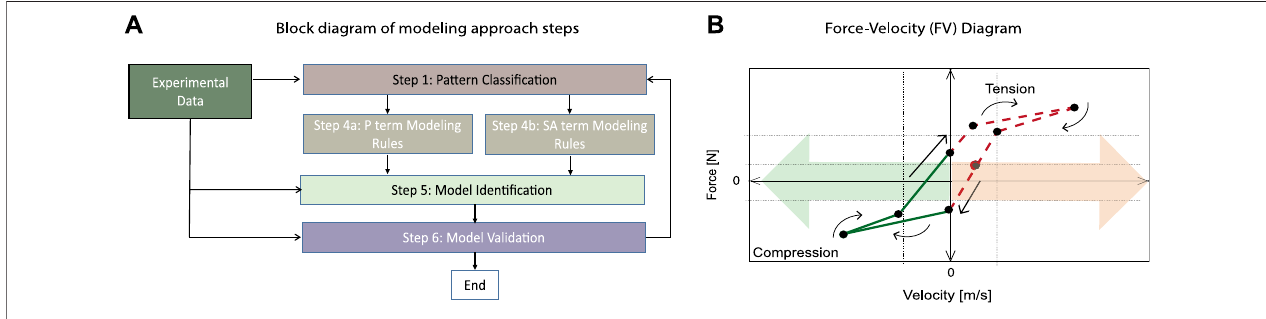
FIGURE 10 | Basic methodology (A) The description of the methodology step by step, (B) A characteristic diagram Force-Velocity pointing the tension and compression shapes of the force, the arrows divide the diagram in positive and negative velocities. Sometimes it will be necessary to have identi fi ed model parameter values depending on the sign of the velocity of the piston.